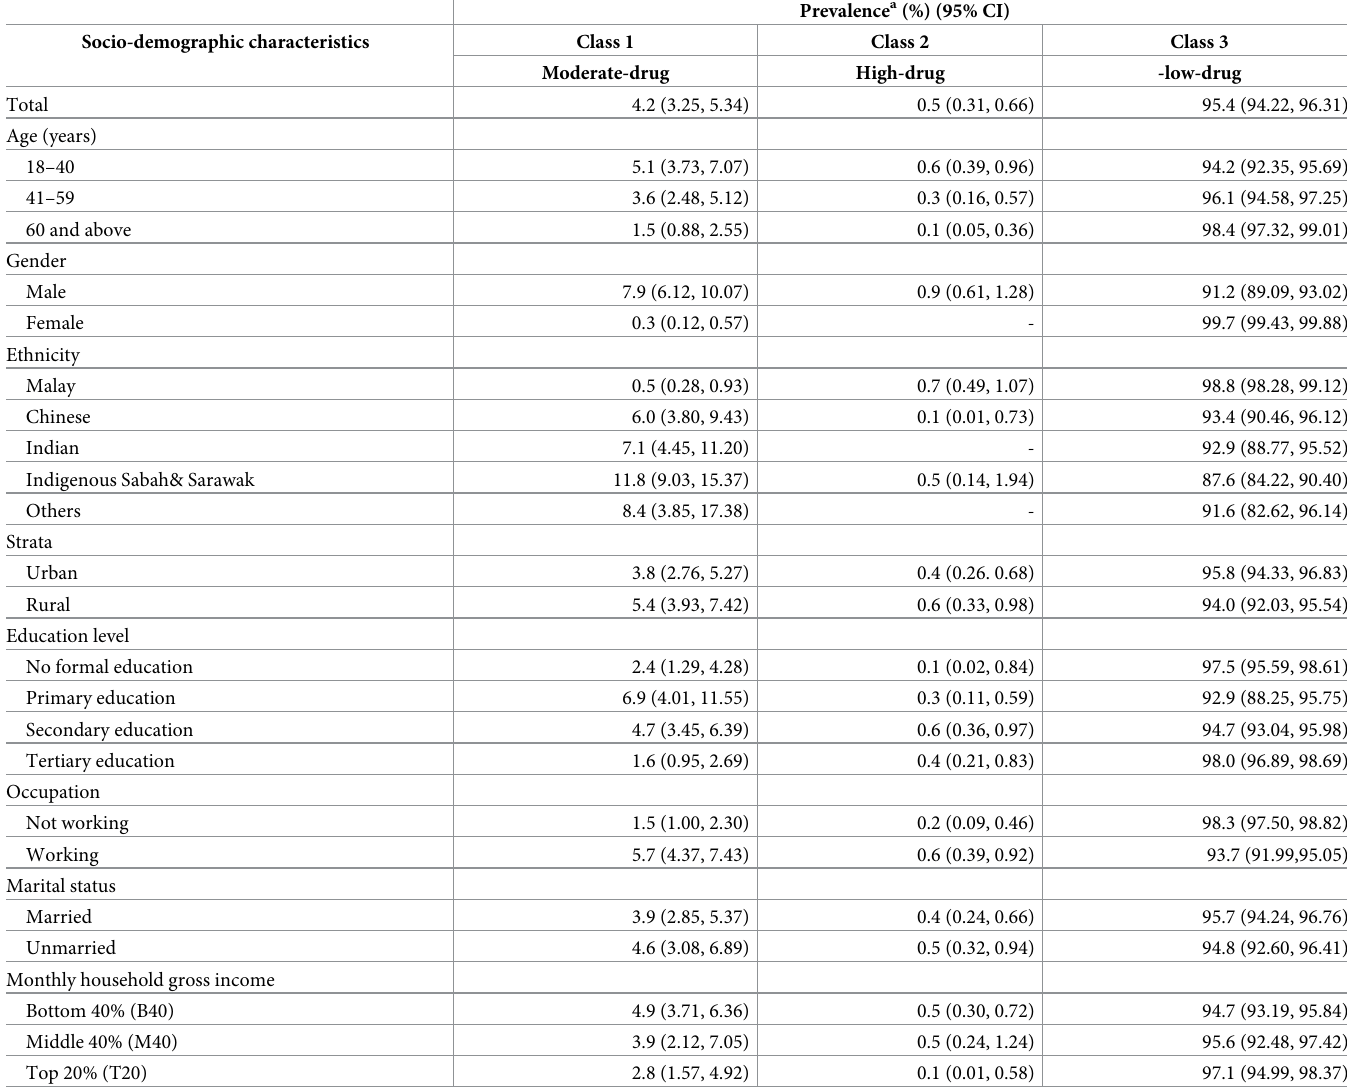
Table 4. Distribution of socio-demographic characteristics by latent class membership.